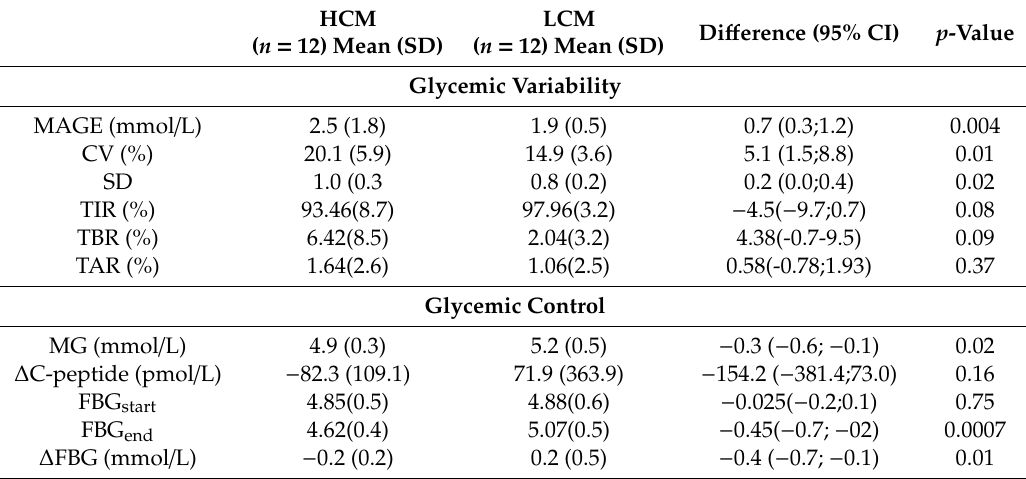
Table 4. Results of treatment e ff